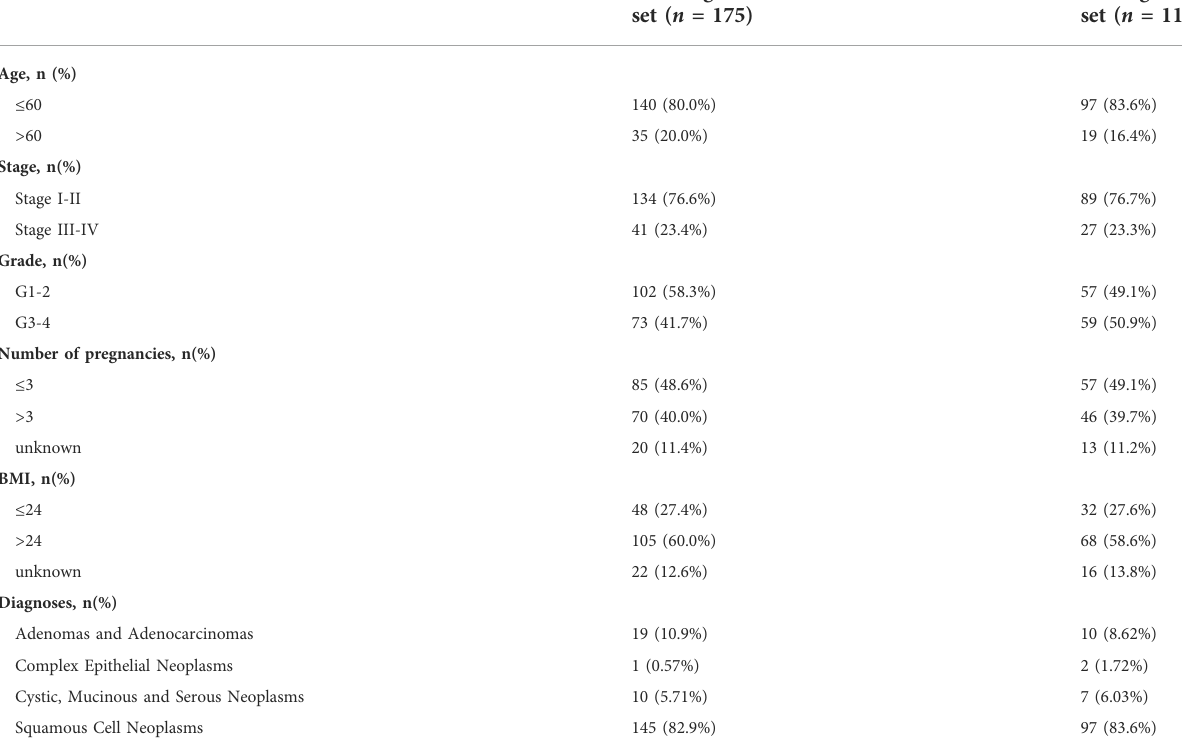
TABLE 1 Baseline demographic